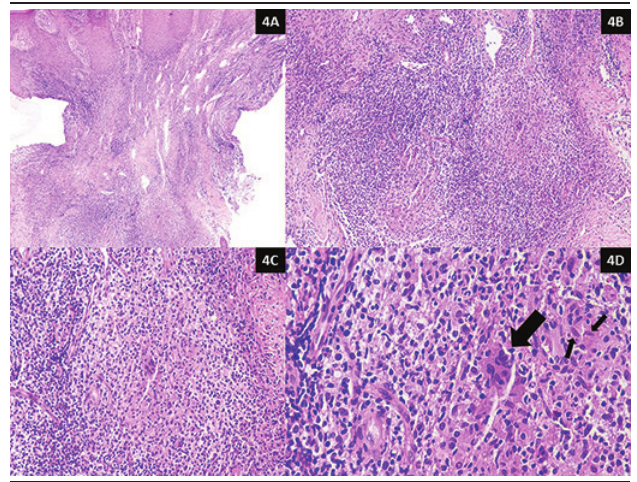
figurE 4 − 4A) photomicrograph of skin biopsy that shows marked reactive epidermal hyperplasia and dense lymphohistiocytic inflammatory infiltrate between the connective bundles of the reticular dermis, with granuloma formation, without caseous necrosis (HE, 20×); 4B) granuloma in the dermis, without caseous necrosis (HE, 40×); 4C) on detail granuloma in the dermis, without caseous necrosis (HE, 100×); 4D) the small arrows indicate some epithelioid histiocytes and the largest arrow points a multinucleated giant cell (HE, 400×) HE: hematoxylin and